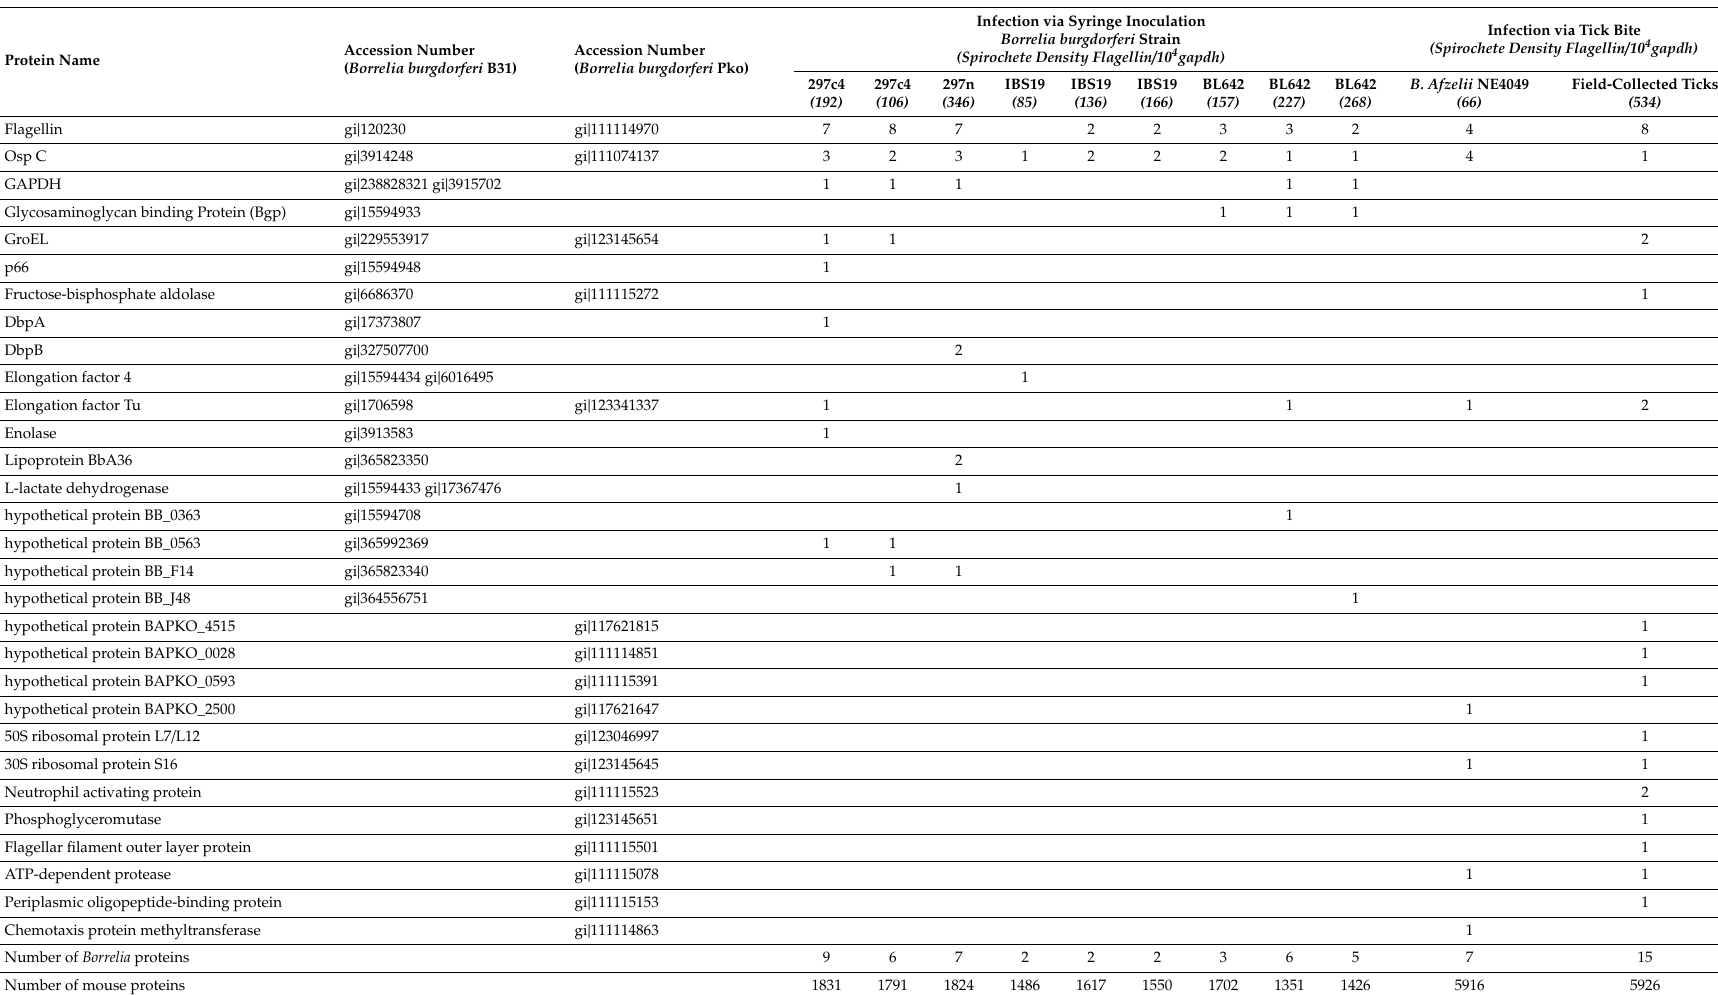
Table 2. Identification of bacterial proteins in mouse skin infected by intradermal inoculation of di ff erent Borrelia burgdorferi strains, or via infectious tick bite. Proteins were identified using Mascot algorithm. Numbers of identified peptides are